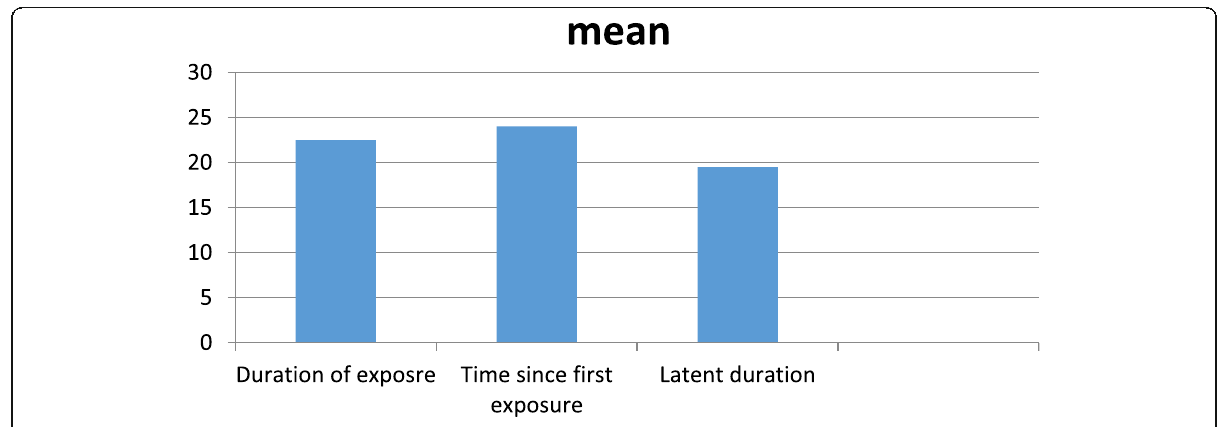
Fig. 1 Descriptive analysis of the studied cases according to duration of different parameters ( n =